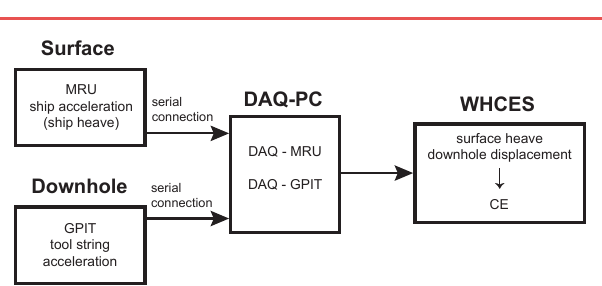
Figure 3. Diagram showing configuration and data flow of surface heave and downhole tool motion data acquisition and heave compensation assessment systems. MRU=Motion Reference Unit; DAQ=Data Acquisition system; WHCES=Wireline Heave Compensation Evaluation System; GPIT=General Purpose Inclinometry Tool. From Liu et al., 2012.